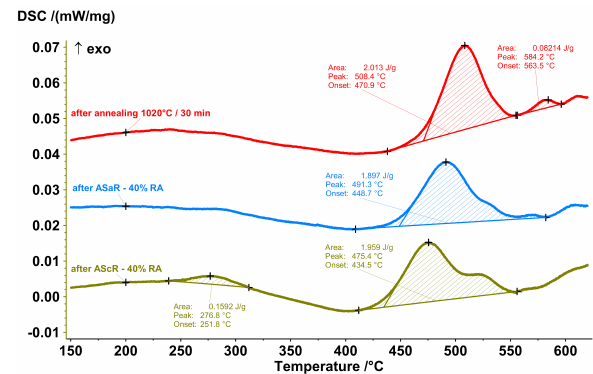
Figure 5: DSC curves of CuCrZr after processing by annealing, ASaR and AScR.